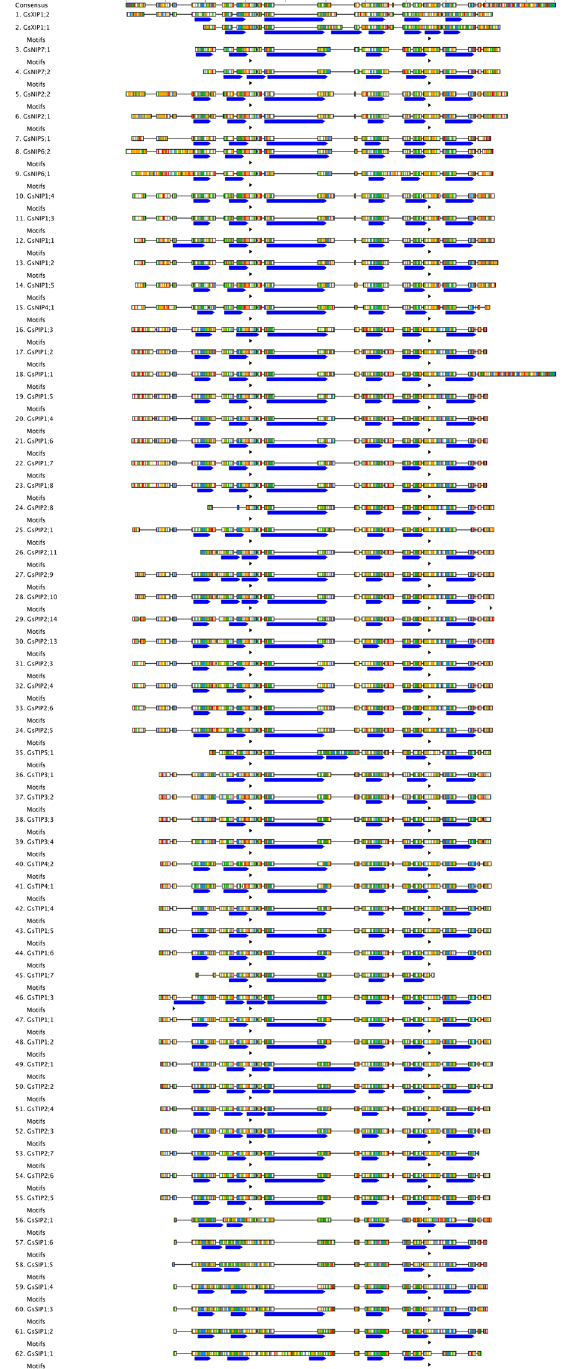
Figure 1. Protein sequence alignment and motif analysis of GsAQPs. Multiple sequence alignment of the full- length amino acid sequences of GsAQPs. The protein sequences were aligned using Muscle alignment tool with default parameters on Geneious 7.1 software. The similarity is depicted through colors in Clustal format. The NPA motifs (black small arrow) were identified using motif detection tool in Geneious 7.1. The transmembrane region (TMR) domains were predicted using transmembrane prediction tools in Geneious 7.1, and depicted as blue colored